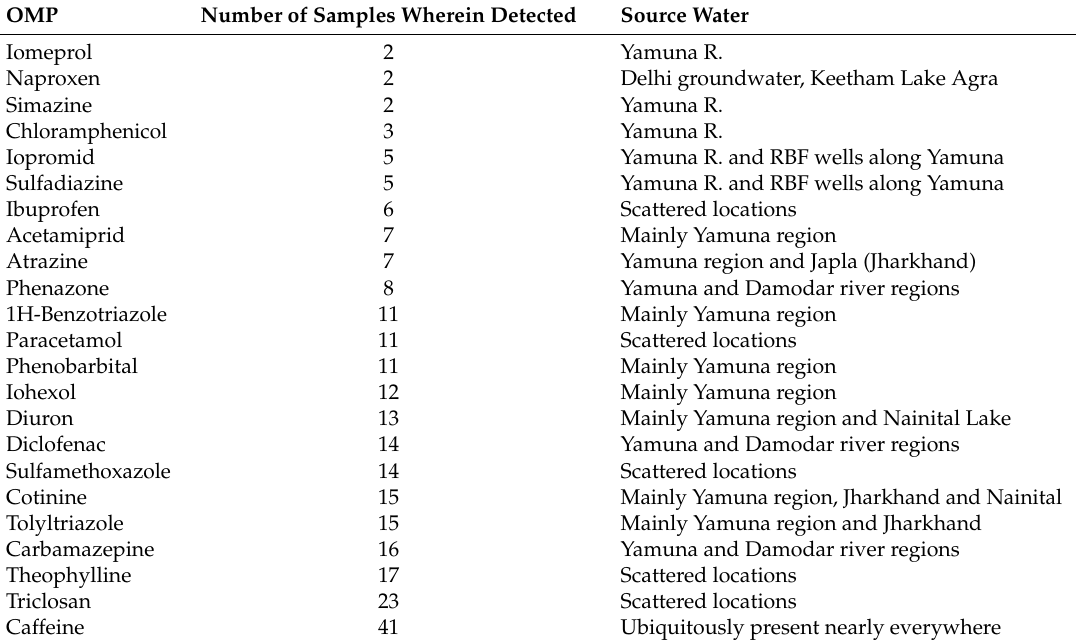
Table A1. Summary of occurrence of organic micropollutants.